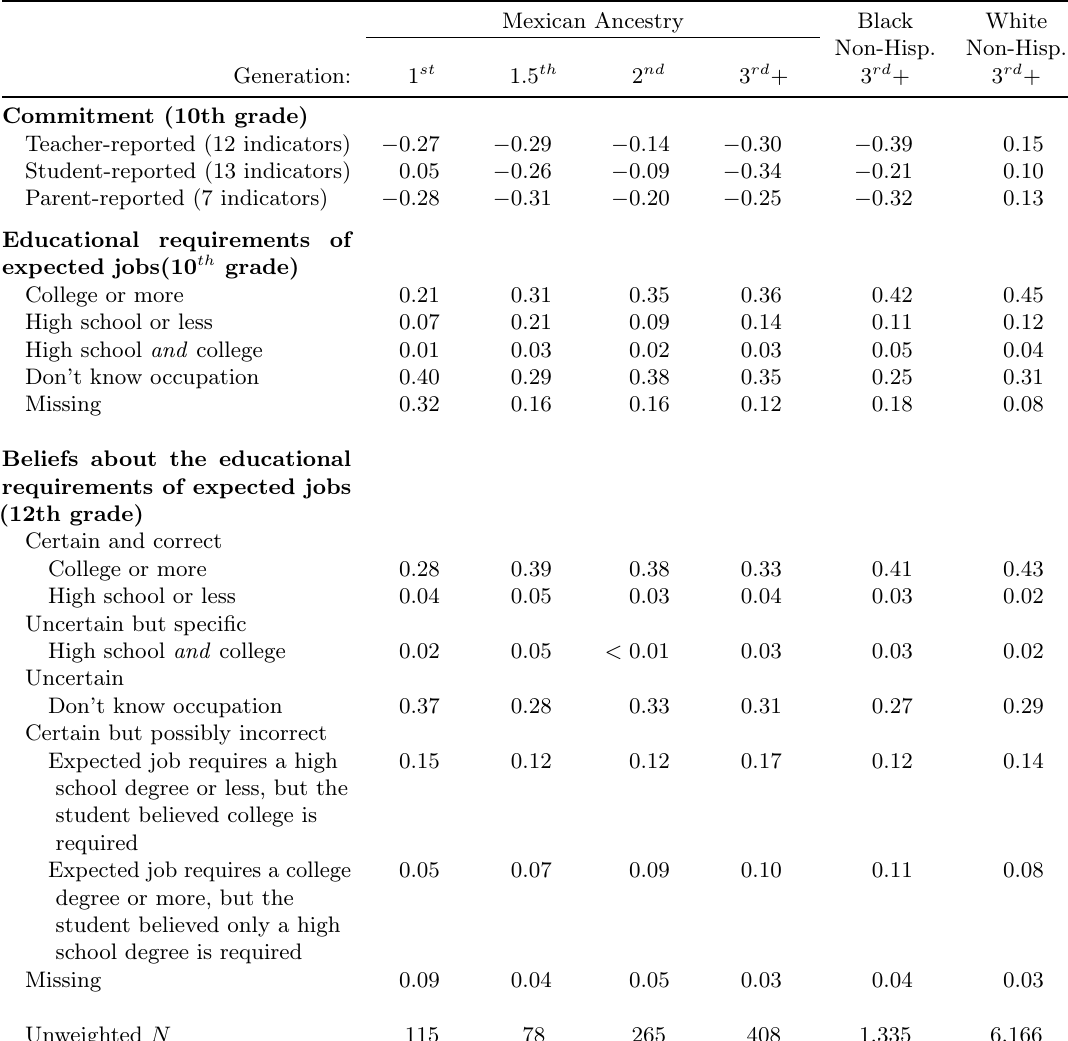
Table 2: Commitment and Beliefs about the Educational Requirements of Expected Jobs for Six Focal Groups Defined by Race-Ethnicity and Immigrant Generation Mexican Ancestry Black White Non-Hisp.